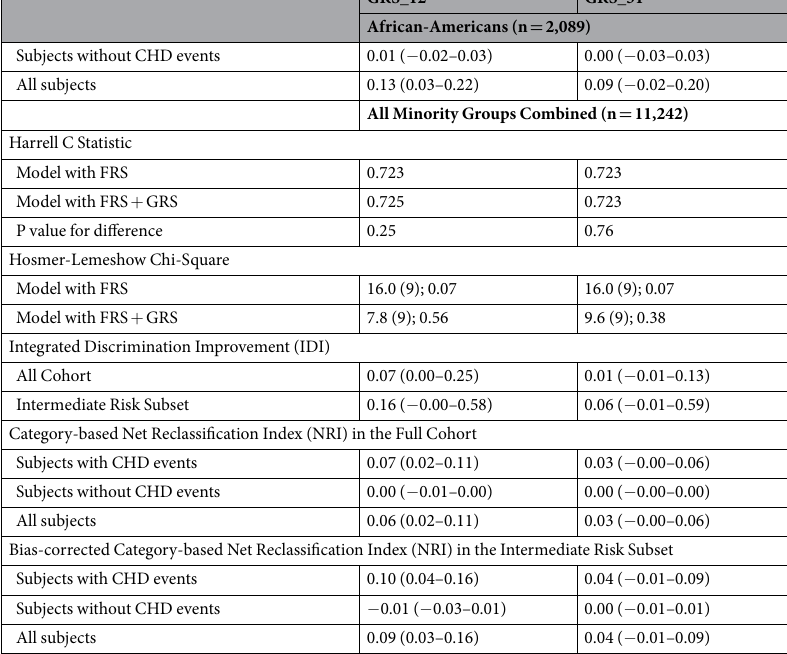
Table 3. Model Calibration, Discriminative Capacity and Reclassification for Incident CHD among GERA minority subjects. CHD denotes coronary heart disease; FRS denotes Framingham Risk Score; GRS denotes genetic risk